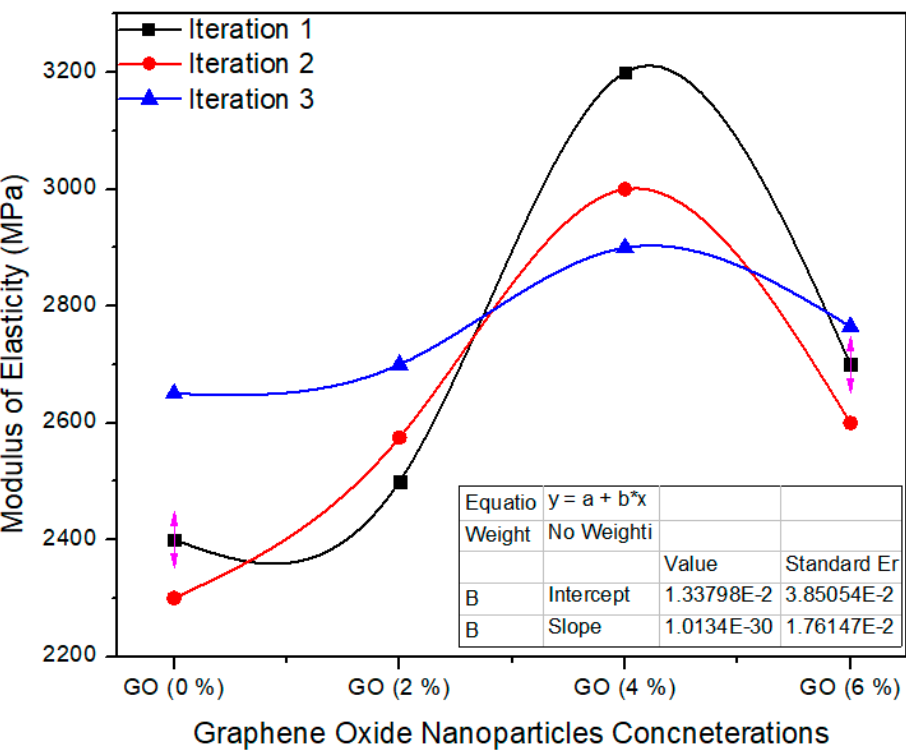
Figure 13. Numerical values of modulus of elasticity (MOE) of various treatments of GO.